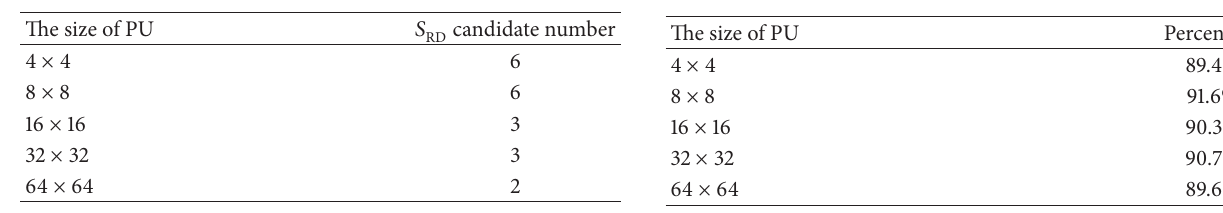
Table 5: Number of candidate modes from 𝑆 RD . Table 6: The conditional probability of 𝑆 RD candidate to be 𝑀 opt